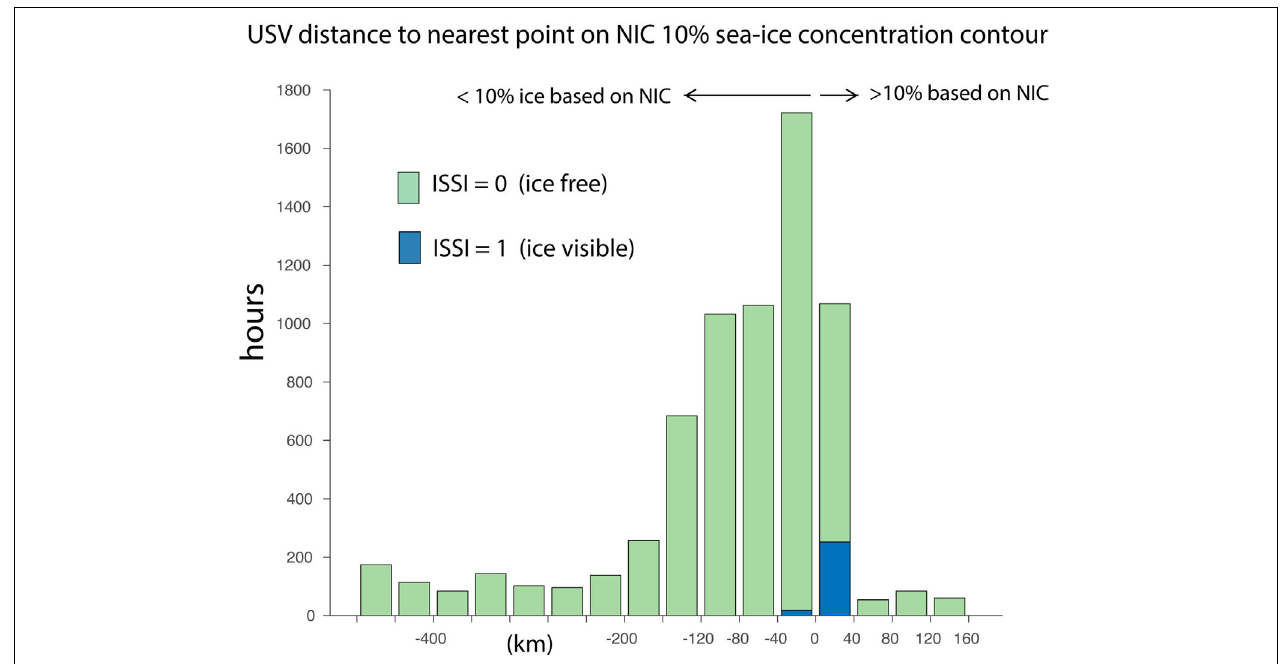
FIGURE 7 | Histogram showing the number of hours that saildrones with cameras (sd-1034, sd-1035, and sd-1036) spent at various distances to the NIC 10% sea-ice concentration contour. Results shown were calculated based on 6-h intervals over the period bounded by their northward transit of Bering Strait on 5 June 2019 through the end of September. The portion of the distribution with sea ice visible from the onboard horizontal or downward photos (ISSI = 1) is shown in blue.